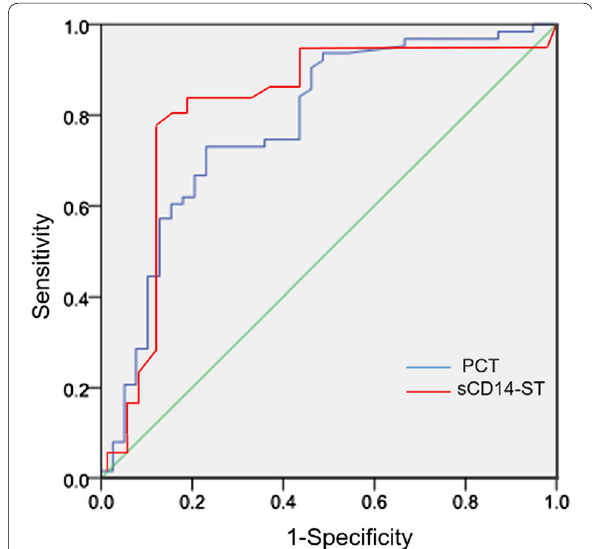
Fig. 2 Receiver operating characteristic (ROC) curve analysis of the variations of PCT and sCD14-ST in SS patients. P < 0.05 was considered